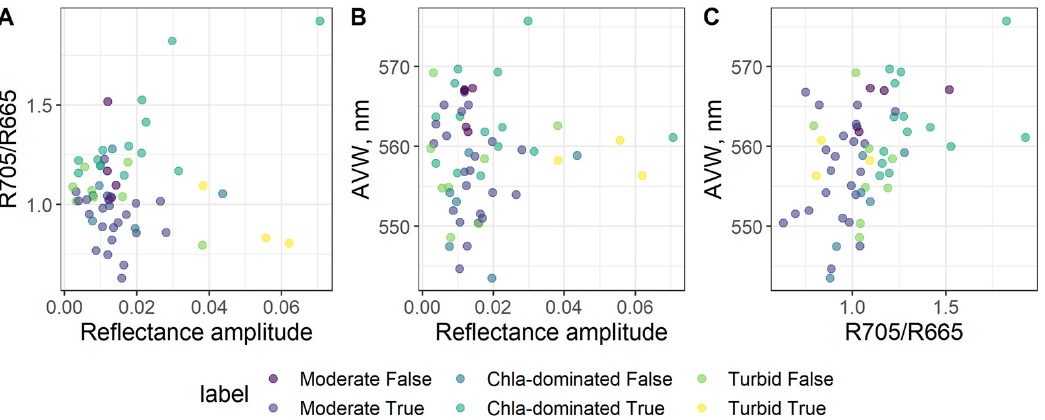
Figure 4. The scatterplots of features ( A ) reflectance amplitude and R705/R665, ( B ) reflectance amplitude and Apparent Visible Wavelength (AVW)), and ( C ) R705/R665 and AVW of correctly classified (Moderate True, Chla-dominated True, and Turbid True) and incorrectly classified (Moderate False, Chla-dominated False, and Turbid False) by Random Forest (RF) classifier observations. The reflectance amplitude and R705/R665 are dimensionless and AVW is expressed in